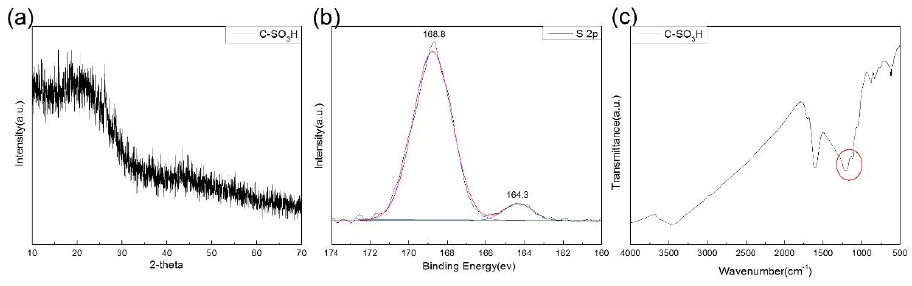
Figure 3. ( a ) X-ray diffraction pattern, ( b ) S2p XPS spectra, and ( c ) FT-IR spectra of C-SO 3 H.